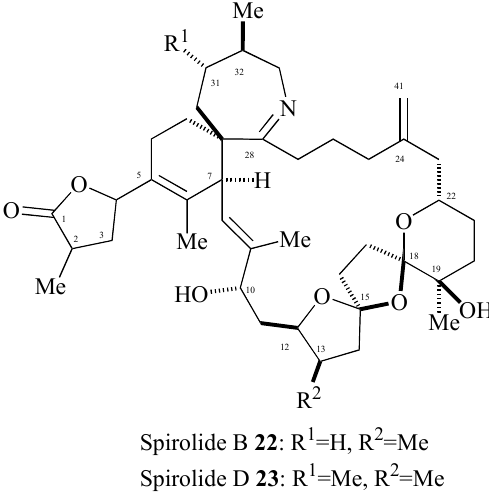
Spirolide B 22 : R 1 =H, R 2 =Me Spirolide D 23 : R 1 =Me, R 2